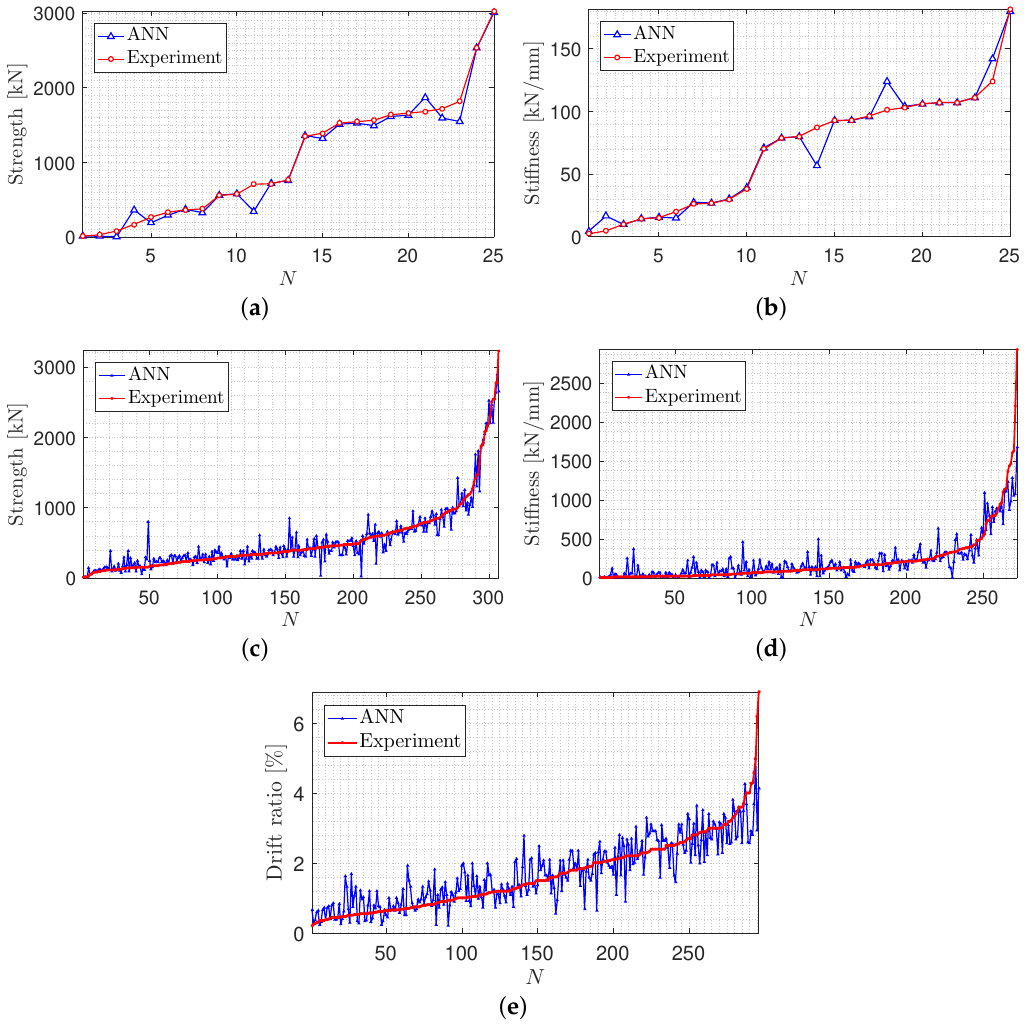
Figure 6. Comparison of measured experiments and predicted ANN meta-model; Note: sorted in ascending order based on experimental data. ( a ) SPSW; Strength, ( b ) SPSW; Stiffness, ( c ) RCSW; Strength, ( d ) RCSW; Stiffness, ( e ) RCSW;